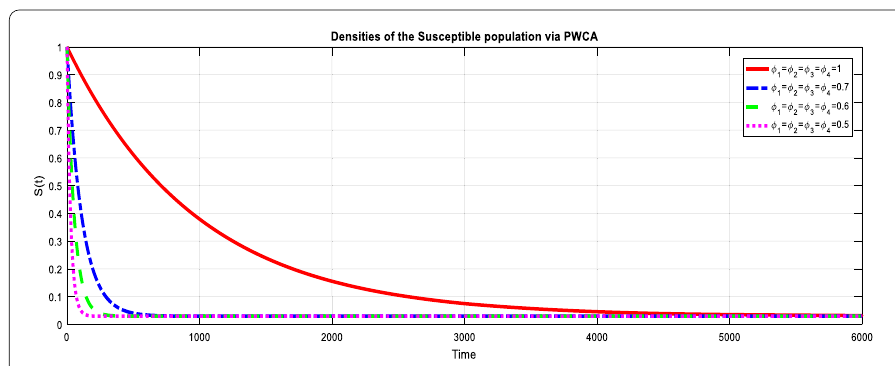
Figure 10 Dynamic of S ( t ) by varying the value of φ